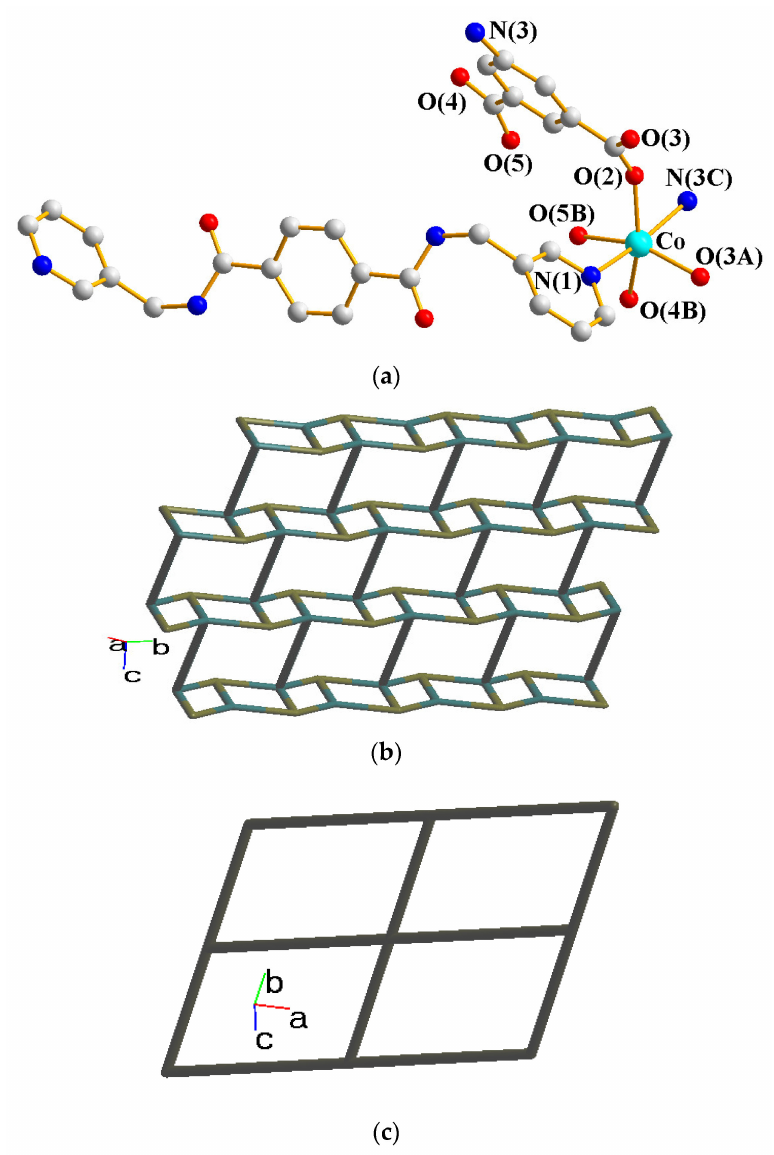
Figure 4. ( a ) Coordination environment about the Co(II) ion in 3 . Symmetry transformations: (A) –x − 1, − y, − z + 2; (B) –x − 1, − y + 1, − z + 2; (C) x − 1, y, z. ( b ) A drawing showing the bey topology. ( c ) A drawing showing the sql